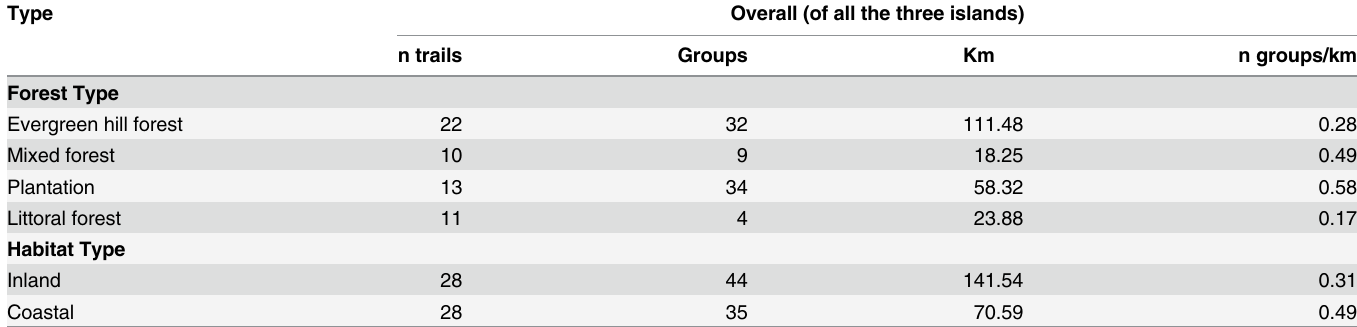
Table 2. Mean number of M . f . umbrosus groups encountered per kilometre in different forest and habitat type in Nicobar Islands.